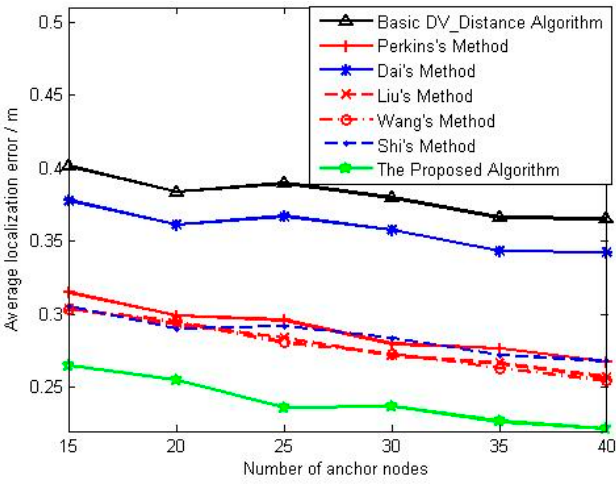
Figure 7. The change curve of average localization error with anchors density.